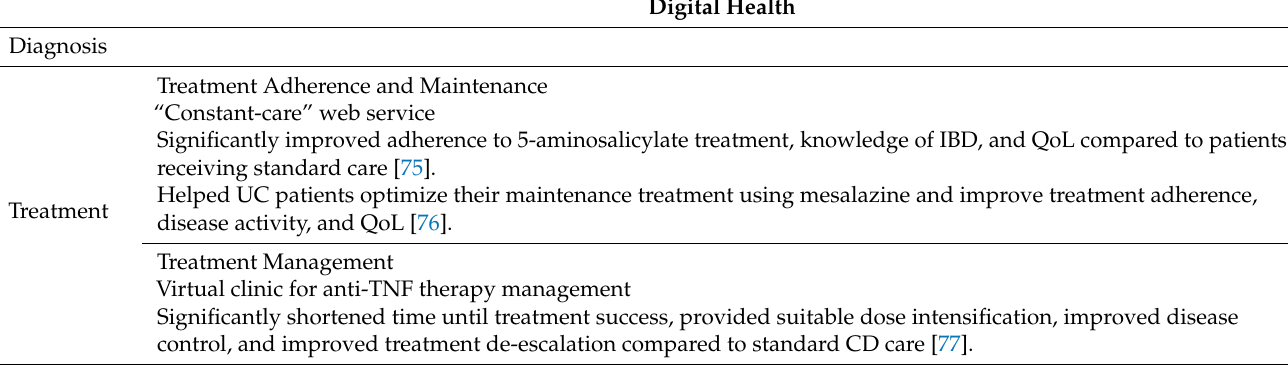
Table 1. Summary of key findings from reviewed articles. Characterizes each article in the review by their focus on digital health (DH) or artificial intelligence (AI) as a discipline, the aspect of inflammatory bowel disease (IBD) care that it addresses (diagnosis, treatment, monitoring, prognosis), and the key finding(s). Underlined and italicized are the categories of each approach to IBD care. In bold are the specific approaches utilized by the investigators. Abbreviations: Crohn’s disease (CD), area under the curve (AUC), random forest (RF), ulcerative colitis (UC), artificial intelligence (AI), inflammatory bowel disease (IBD), area under the receiver operator curve (AuROC), tumor necrosis factor (TNF), machine learning (ML), Telemonitoring of Crohn’s Disease and Ulcerative Colitis (TECCU), Simple Clinical Colitis Activity Index (SCCAI), TELEmedecine for Patients with Inflammatory Bowel Disease (TELE-IBD), quality of life (QoL), fecal calprotectin (FC), and health-related quality of life